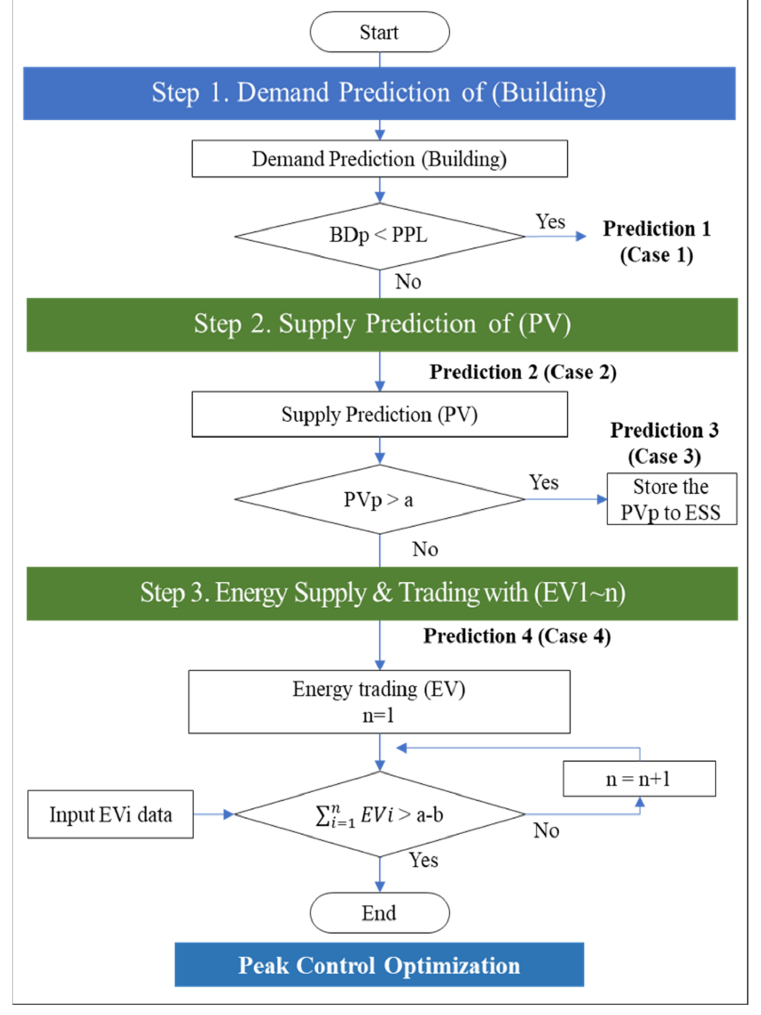
Figure 11. Three ‐ step energy supply strategy algorithm. Figure 11. Three-step energy supply strategy